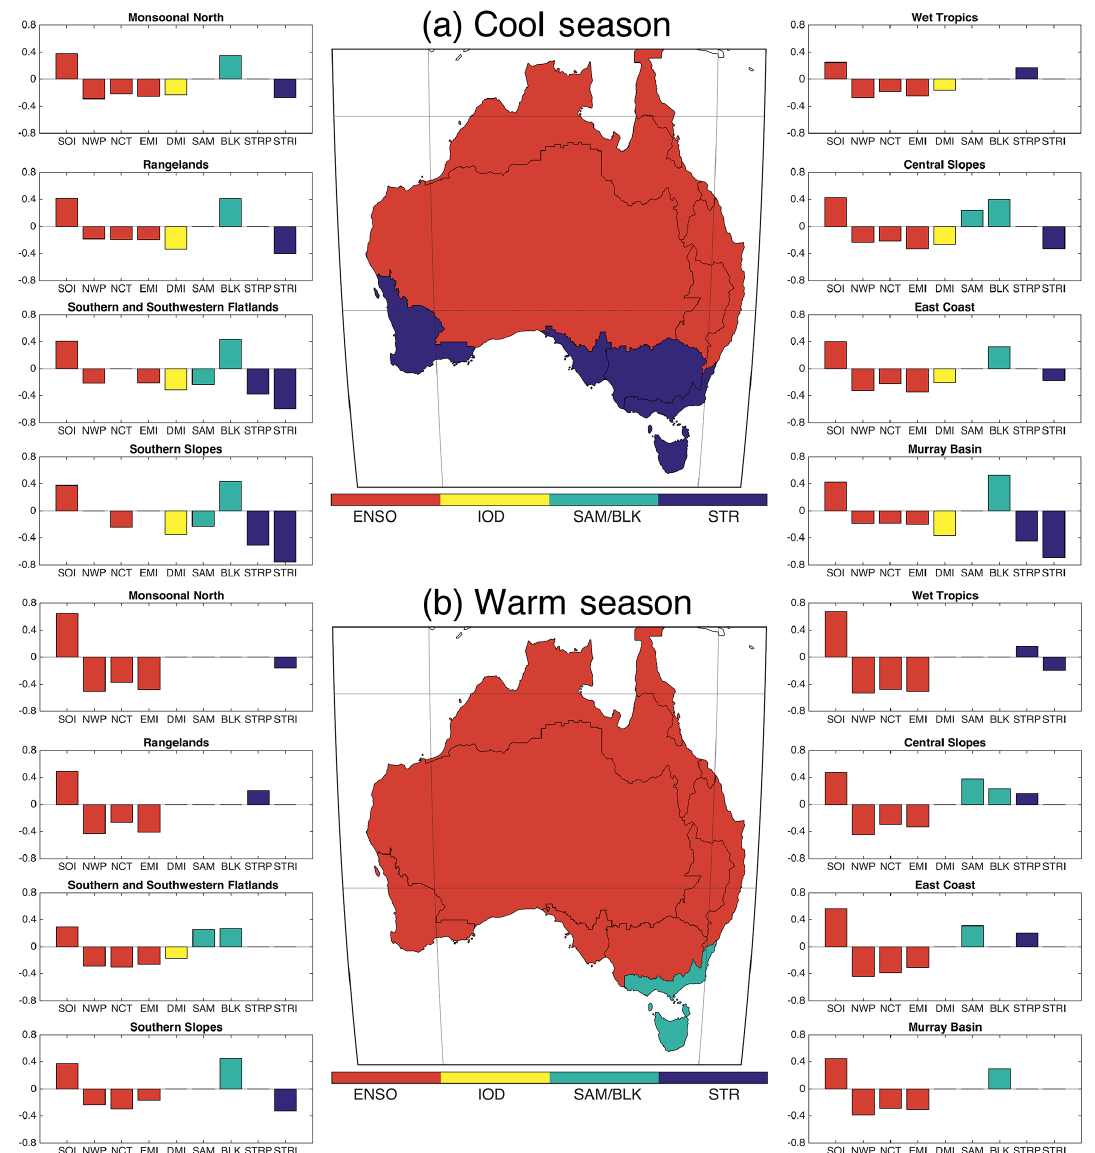
Figure 2. NRM regions and their dominant climate influences on (a) cool- and (b) warm-season rainfall. Centre maps show the climate driver with the highest correlation to seasonal precipitation according to the NRM regions. The drivers are summarised into four major categories: ENSO, IOD, SAM/BLK and STR (see Table 1a). Individual correlations between regional rainfall and each climate driver index are given in surrounding bar plots. Only significant correlations exceeding the 10% significance level are